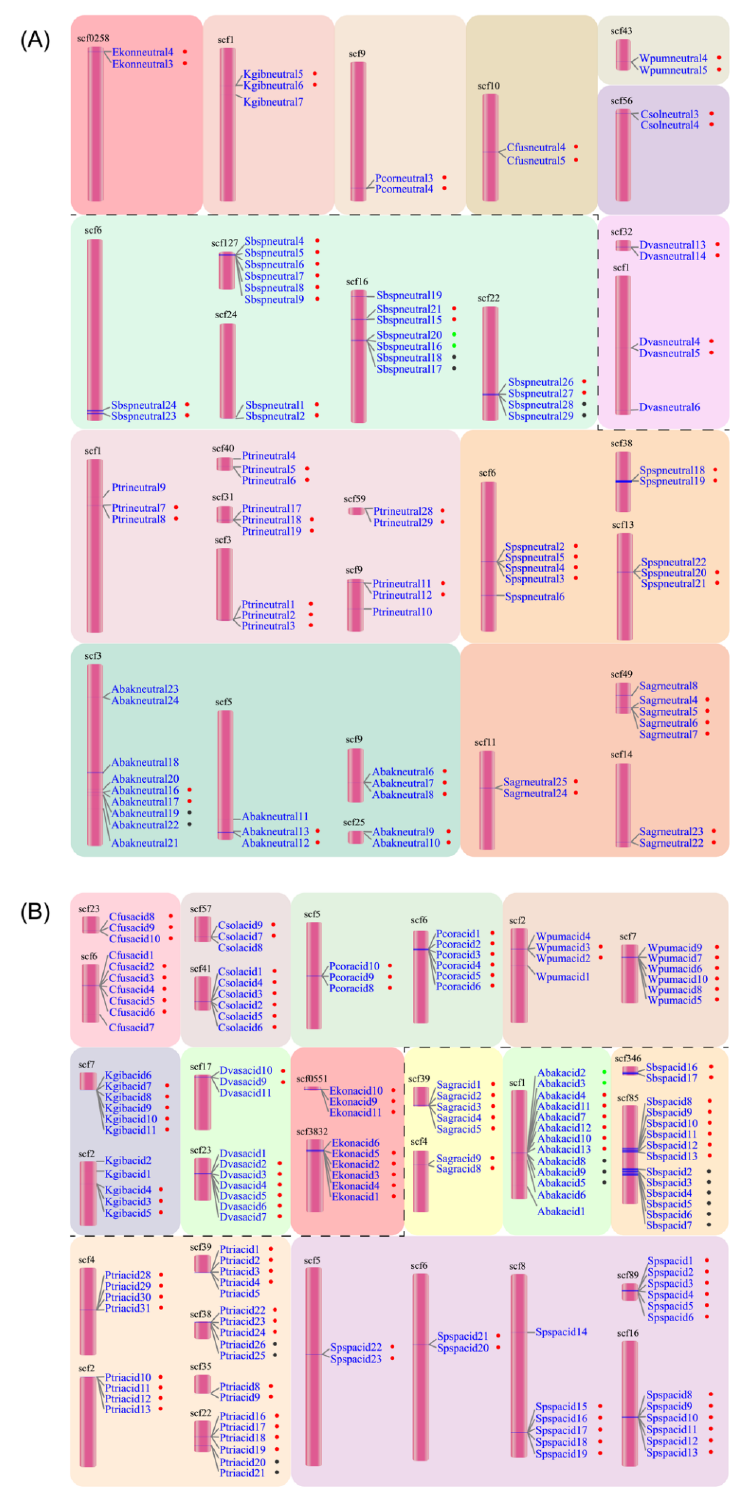
Figure 2. Tandem duplication events of neutral ( A ) and acid ( B ) lipases occurred in 12 fig wasp species. The pollinator fig wasps are above the black dashed line, and the non-pollinating fig wasps are below the black dashed line. All the lipase gene names are listed close to the scaffolds. The dots beside the names with the same color indicate the same tandem duplication event. The first four letters of each gene name are the abbreviation of each fig wasp